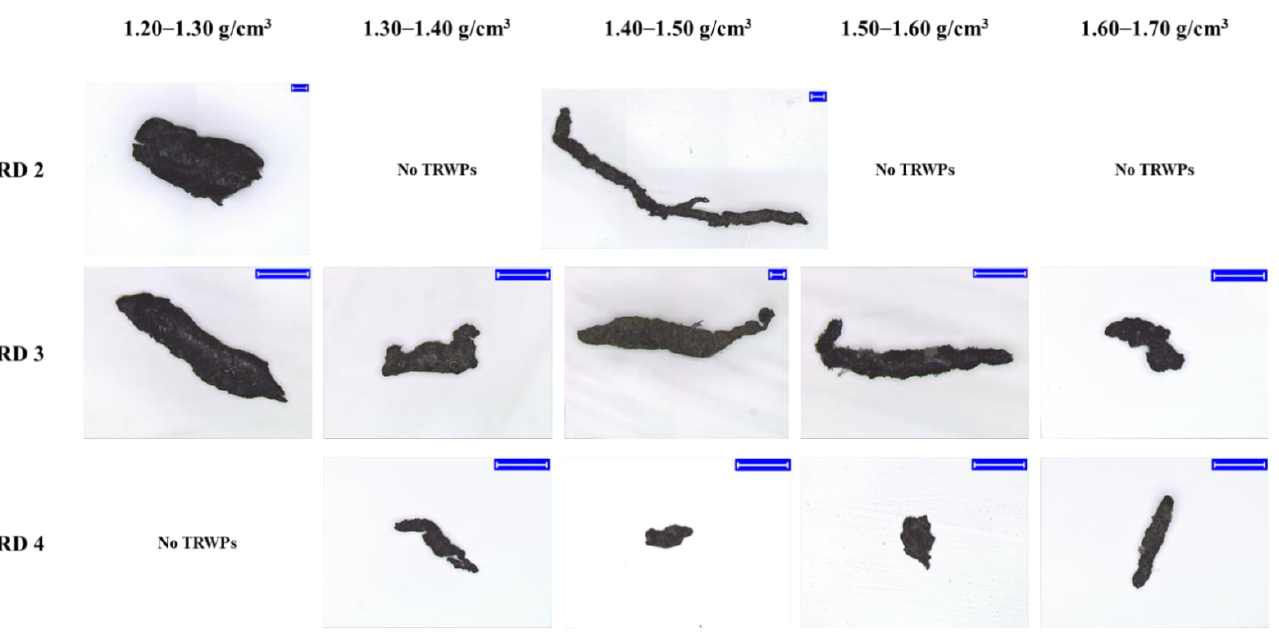
Figure 8. Magnified images of the TRWPs classified from the road samples. The blue scale bar is 100 µm.